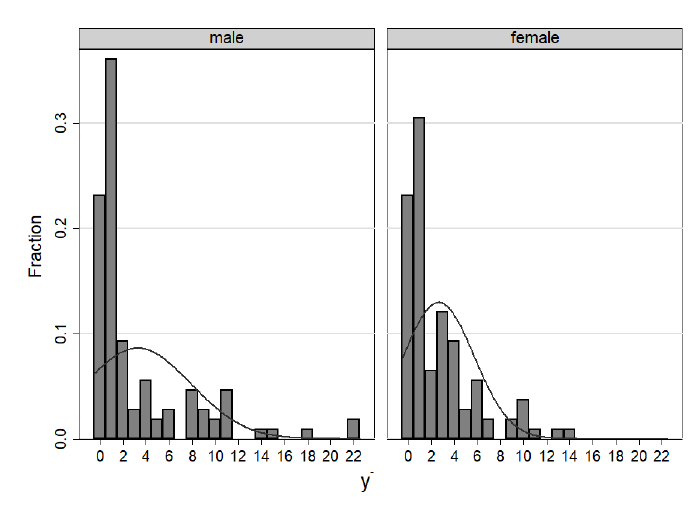
Figure 8. Distribution of average downward adjusted offer y − by sex.